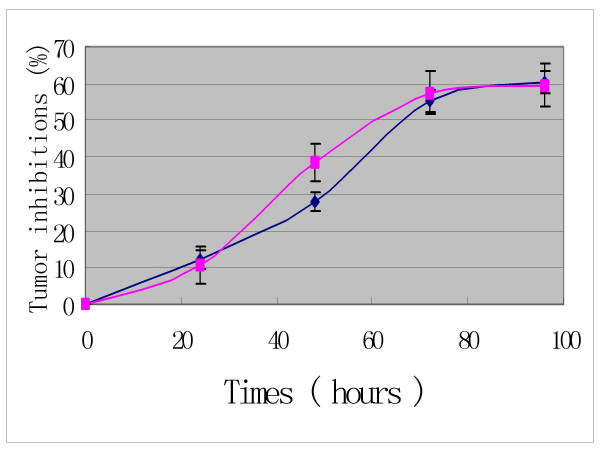
Time – response curve of probimane inhibiting a human mammary cell line (MDA-MB-468). MTT method was used. A: Pro concentration at 5 μM (dark); B: Pro concentration at 0.5 μM (purple).